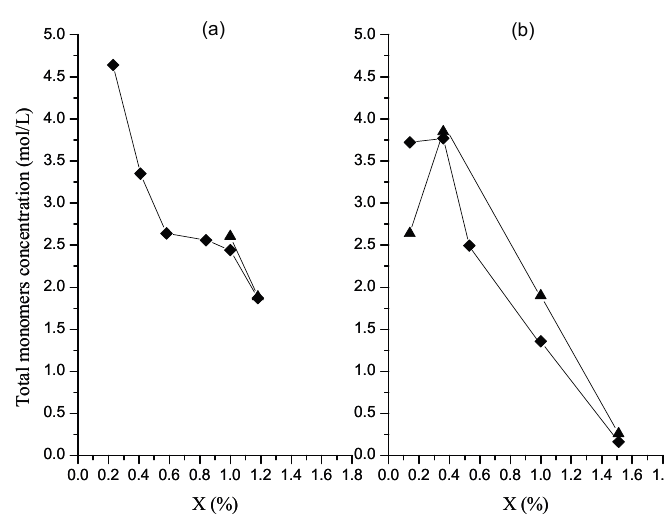
Figure 9. Evolution of total monomers concentration inside nanoparticles with global conversion in polymerizations at 0.05 ( a ) and 0.15 ( b ) g/min in organic dosing rate. Runs M ( ♦ ); runs MR ( ▲